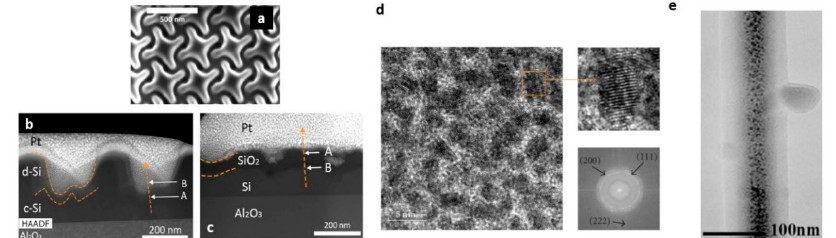
Figure 2. ( a ) Top view of FIB-milled 3D chiral photonics silicon nanostructures on a single crystal silicon film on sapphire. The period of the nanostructures was set to 370 nm. ( b , c ) Scanning transmission electron microscopy (STEM) cross-section images of the nanostructures before and after the annealing. A previous coating of a layer of platinum deposited in two stages has been applied as a protective layer. The STEM image taken before the annealing ( b ) shows: The presence of gallium implanted on the layer of damaged silicon (d-Si in the image) above the surface of the nanostructure, amorphous silicon inclusions (c-Si in the image), and the deposited protective platinum layer. The STEM image taken after the annealing shows that the d-Si is removed and a layer of silicon oxide is formed. Reproduced with permission from [68]. ( d ) HRTEM images of deposited Pt films grown on a copper grid show bright and dark regions associated to amorphous C region of carbon matrix and Pt grains, respectively. The inset shows the magnification of a Pt grain in order to observe the atomic planes, while the image below represents the diffraction spots of the Pt grains that correspond to the (200), (111), (222), and (202) atomic planes of fcc. Reproduced with permission from [76]. ( e ) TEM of an amorphous diamond like carbon (DLC) pillar. One can see the dark contrast of nanograins from the gallium core, while the bright part is the thick carbon shell, classified as diamond like carbon. Reproduced with permission from [80].